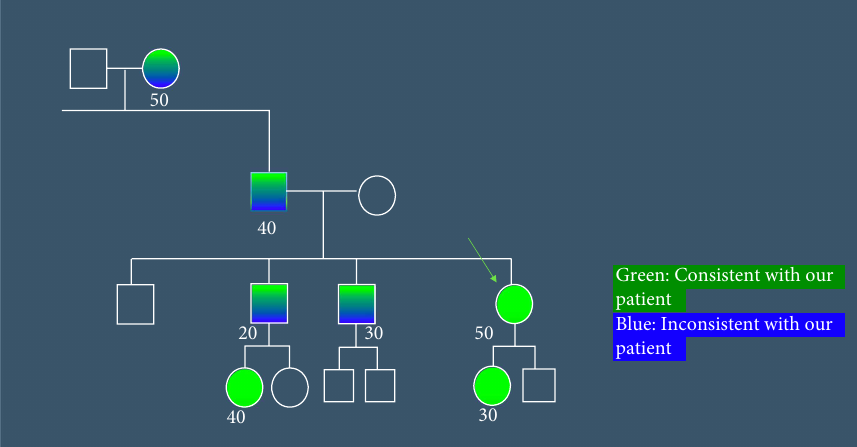
Figure 4: Family pedigree with features consistent and inconsistent with our